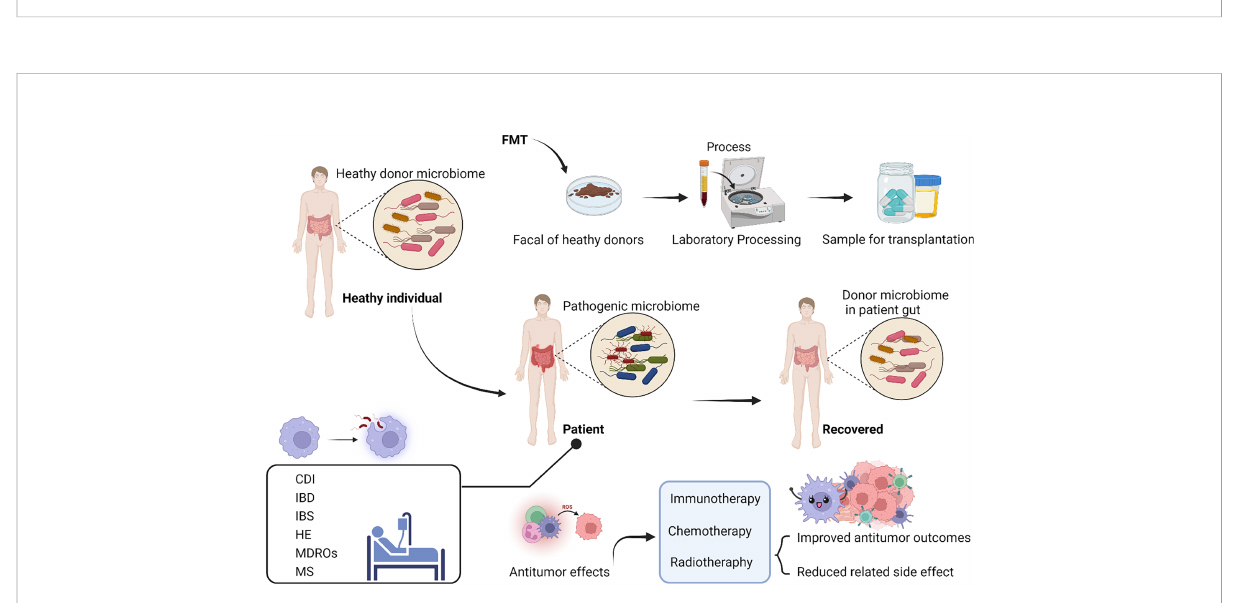
FIGURE 4 Fecal microbiome transplantation (FMT) from a healthy donor improves the process of dysbiosis and various disorders in patients. FMT can treat many diseases including Clostridioides Dif fi cile infections (CDIs), colonized with multidrug-resistant organisms (MDROs), in fl ammatory bowel disease (IBD), irritable bowel syndrome (IBS), and neurological disorders including multiple sclerosis (MS), hepatic encephalopathy (HE), Parkinson ’ s disease, diabetic neuropathy and so on. On the one hand, FMT may improve the gut microbiological environment in patients with insigni fi cant therapeutic ef fi cacy or severe side effects. On the other hand, FMT has antitumor effects and/or reduces the occurrence of associated toxic events (combination FMT with immunotherapy, chemotherapy or radiotherapy). (The fi gure was created with Biorender.com).